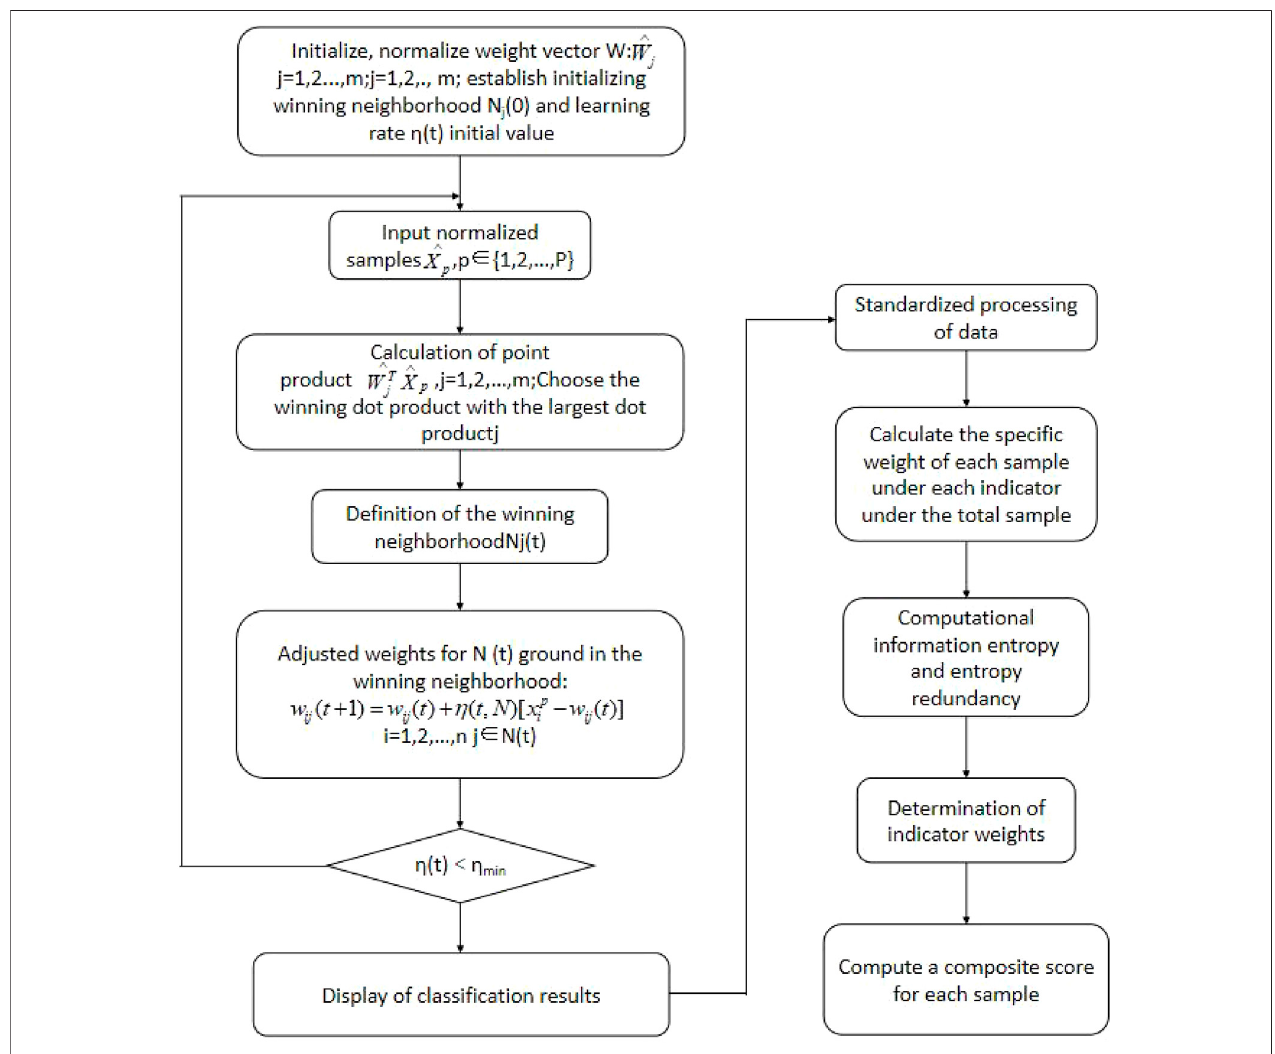
FIGURE 3 | Based on SOM and the entropy method, the calculation principle and fl ow of the water quality assessment are demonstrated.